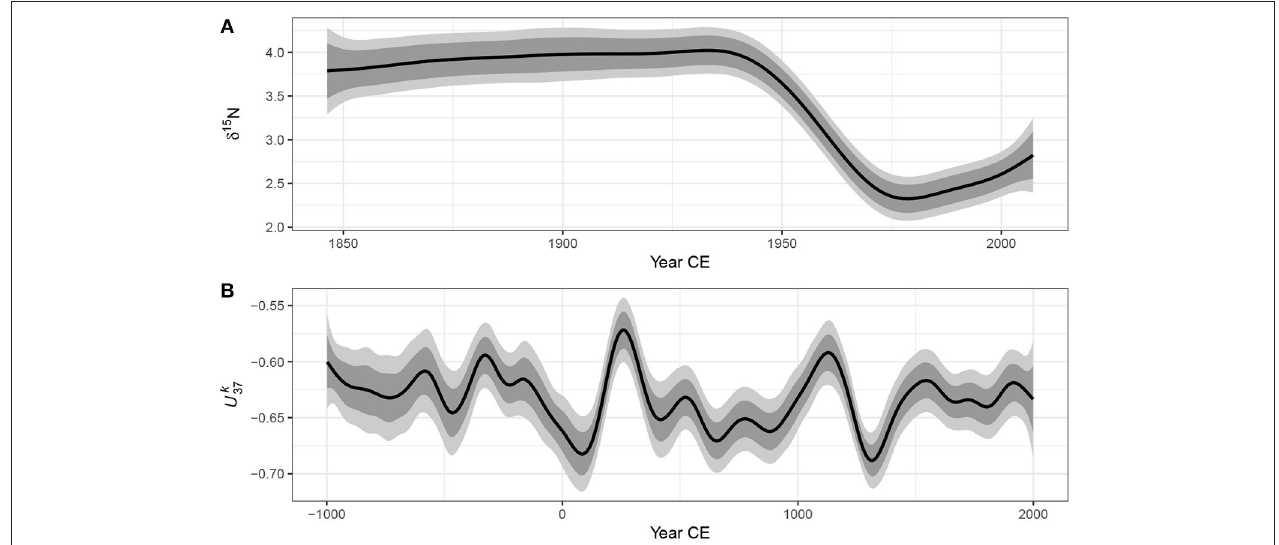
FIGURE 9 | 95% simultaneous confidence intervals (light grey bands) and across-the-function confidence intervals (dark grey bands) on the estimated trends (black lines) for the Small Water δ 15 N (A) and Braya-Sø U K 37 (B) time